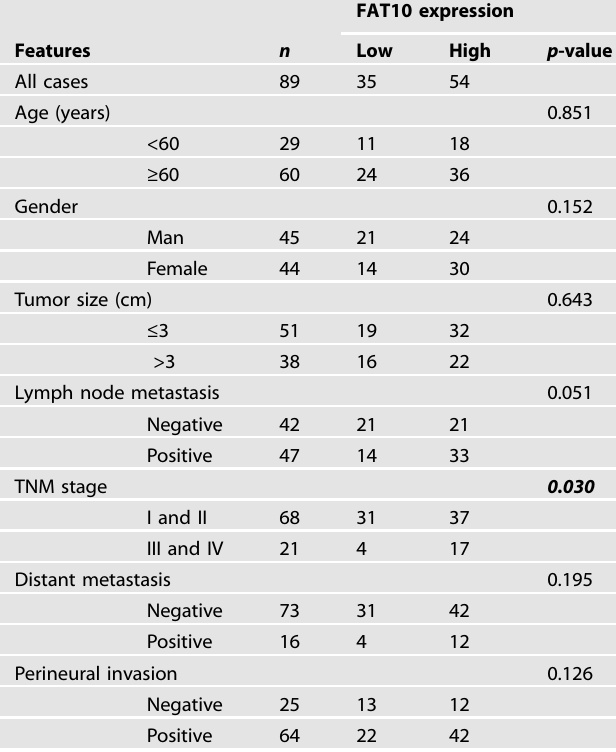
Table 1. The relationship between FAT10 expression and clinicopathological characteristics in PC